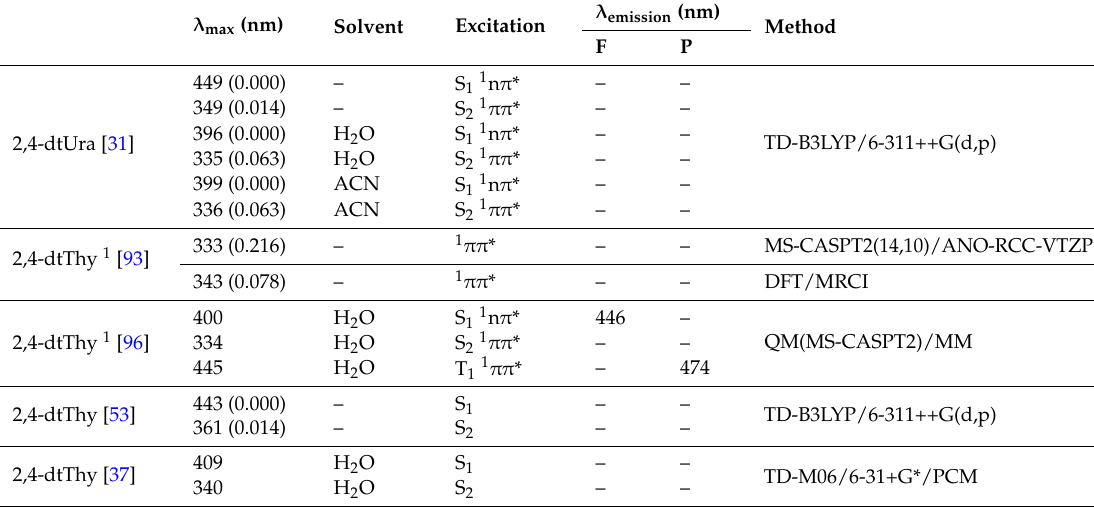
Computed absorption and emission properties of 2,4-dithiopyrimidine derivatives. In parenthesis the oscillator strengths are shown. F: Fluorescence; P: